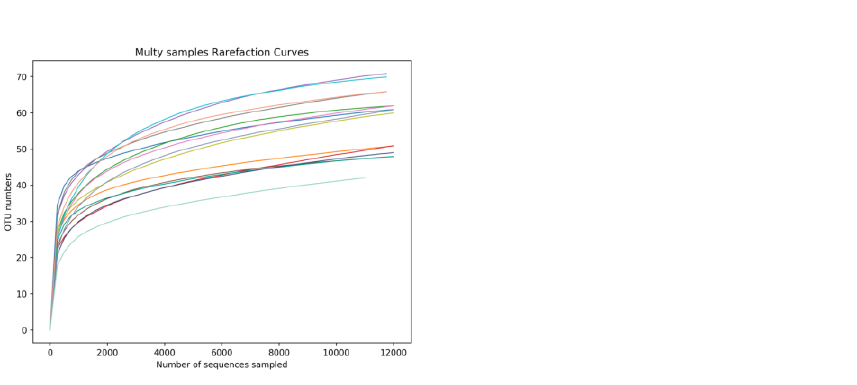
Figure A2. Rarefaction curves for all gut bacteria community. Each curve in the graph represents different crabs. As the sequencing depth increased, the number of gut bacteria increased the relative abundance increased in rarefaction curves. Table A1. Primer sequences for housekeeper gene and targeted genes.